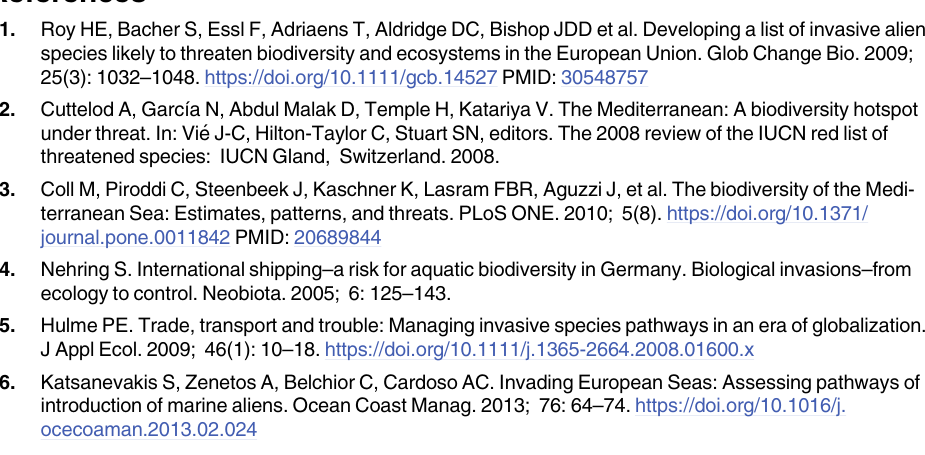
S1 Table. Environmental data. Temperature (˚C) and salinity data during the sampling